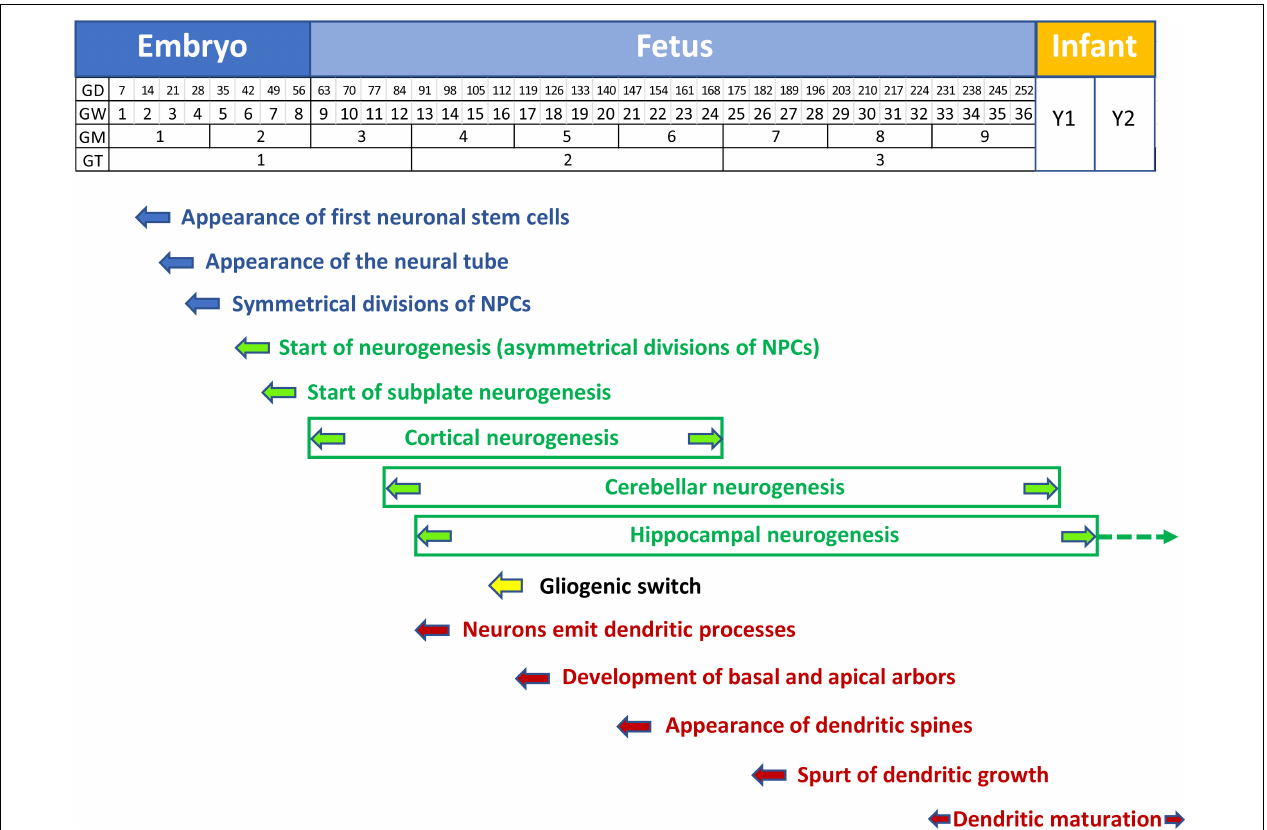
FIGURE 2 | Timeline of neurogenesis, gliogenesis, and neuron maturation in the human brain. Neural stem cells appear at GD14. Symmetrical divisions of NPCs that start at GD28 gradually shift at GD42 to neuron-producing asymmetrical divisions. Cortical neurogenesis starts at GW9 and is completed at GW24-25. Cerebellar and hippocampal neurogenesis continue beyond birth. Cerebellar neurogenesis stops at month 5. Hippocampal neurogenesis is largely completed by the first year but continues very slowly throughout life (dashed arrow). Starting from GW16 neuron-producing divisions are gradually replaced by glia-producing divisions (gliogenic switch). Gliogenesis extends beyond birth (yellow arrow). Neurons emit dendritic processes starting from GW13, but the dendritic spurt takes place much later at GW26, associated with the appearance of dendritic spines. Dendritic maturation begins shortly before birth (GW34) and is largely completed by the second postnatal year. Note that graphic representation of the postnatal time is not to scale with embryonic and fetal periods. Abbreviations: GD, gestation day; GM, gestation month; GT, gestation trimester; GW, gestation week; and Y,